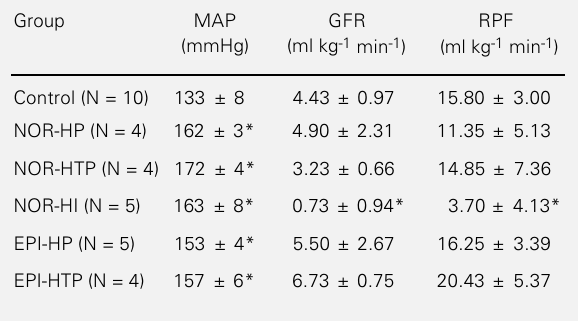
Table 1 - Mean arterial pressure (MAP), total glomerular filtration rate (GFR) and renal plasma flow (RPF) in the control group and in the subgroups of rats treated with norepinephrine (NOR) and epinephrine (EPI), showing a homogeneously (HP) and heteroge- neously (HTP) perfused and homogeneously ischemic (HI) pattern.